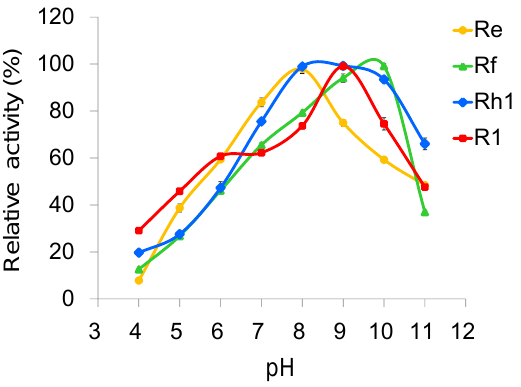
Figure 6. Effect of pH on the enzymatic activity of UGT109A1.